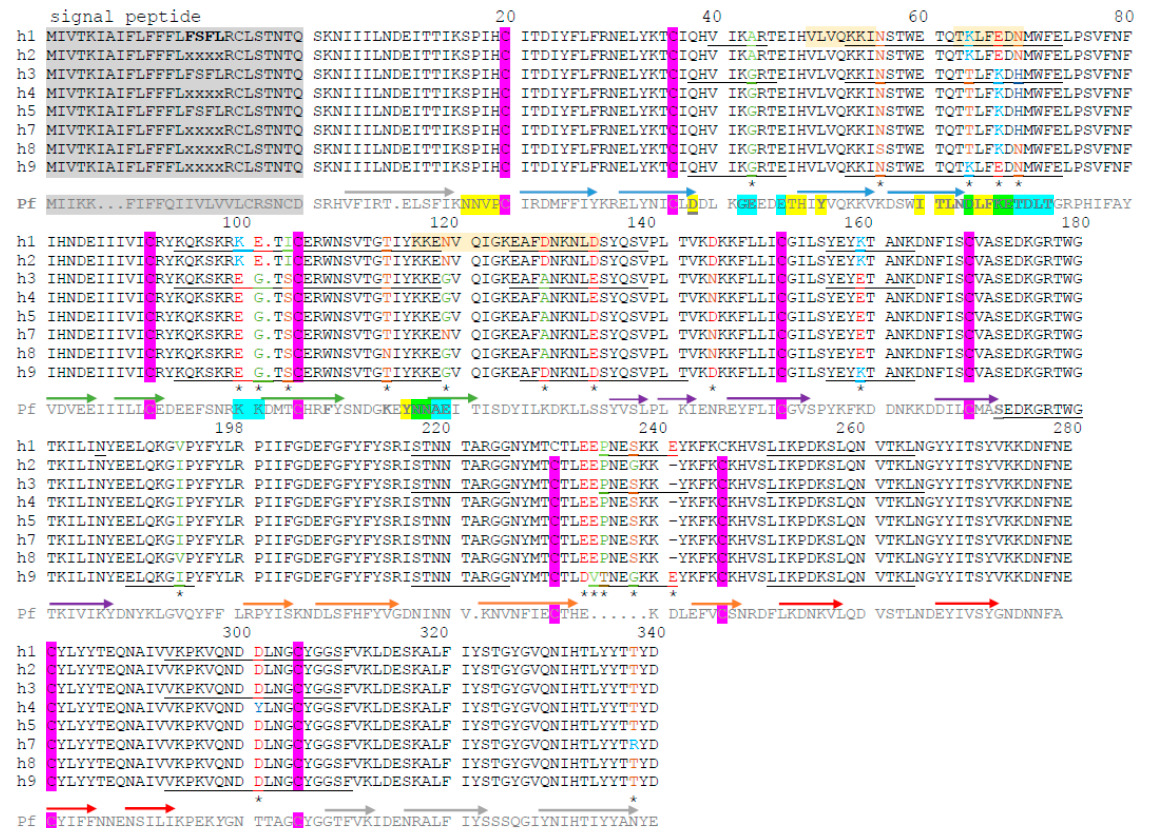
Figure 5. Amino acid variation in P. vivax CyRPA from the Southern Mexican isolates. Haplotypes h1-h9 are shown. The conserved residues of the amino acid cysteine are marked with a purple box. The underlined peptide segments had a score above 0.50, resolved using BepiPred lineal epitope prediction 2.0, and are likely to participate in B-cell epitopes. Amino acid changes are indicated by color according to their characteristics. In red, D (Asp) and E (Glu), both polar negatively charged amino acids; in bright blue, K (Lys) and R (Arg), both positively-charged polar amino acids. Brown and light green indicate polar and non-polar amino acids, respectively. FSFL conserved residues were detected in all the sequences obtained in this study, and genomic sequences lacked information from this segment (PlasmoDB). Haplotypes h5 and h6 had a similar amino acid sequence. Pf indicates the P. falciparum orthologous sequence, in which the strands of β sheets are indicated using arrows and a different color for each sheet—yellow [4] and blue [20] indicate residues found to be participating in conformational B epitopes by different studies; green indicates residues suggested by both studies [4,20]. Pf D66 is a residue that is relevant for antibody binding to a conformational epitope [20]. Dashes indicate an absence of sequence and dots indicate indels. * indicate amino acid changes among Southern Mexican isolates.